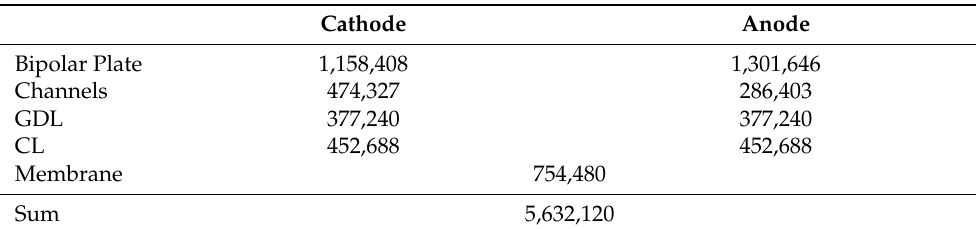
Table 3. Number of computational cells of homogenized channel approach.